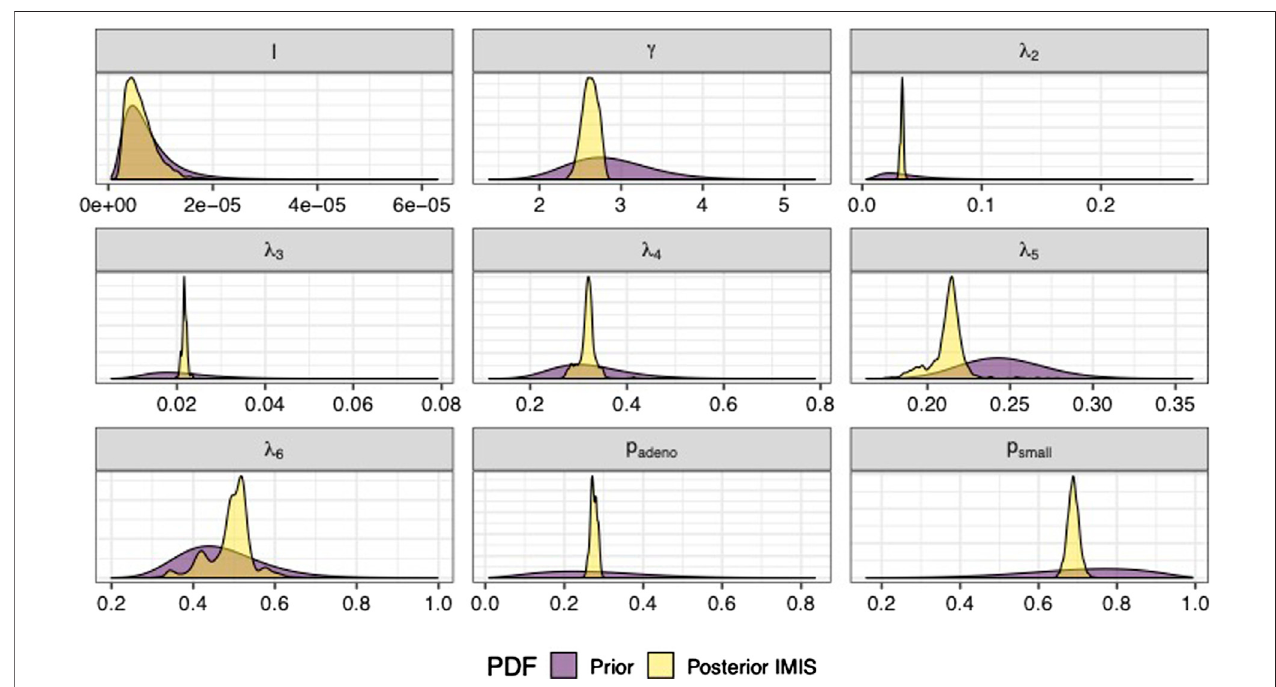
FIGURE 2 | Prior and posterior marginal distributions of calibrated parameters of the microsimulation model of the natural history of CRC.